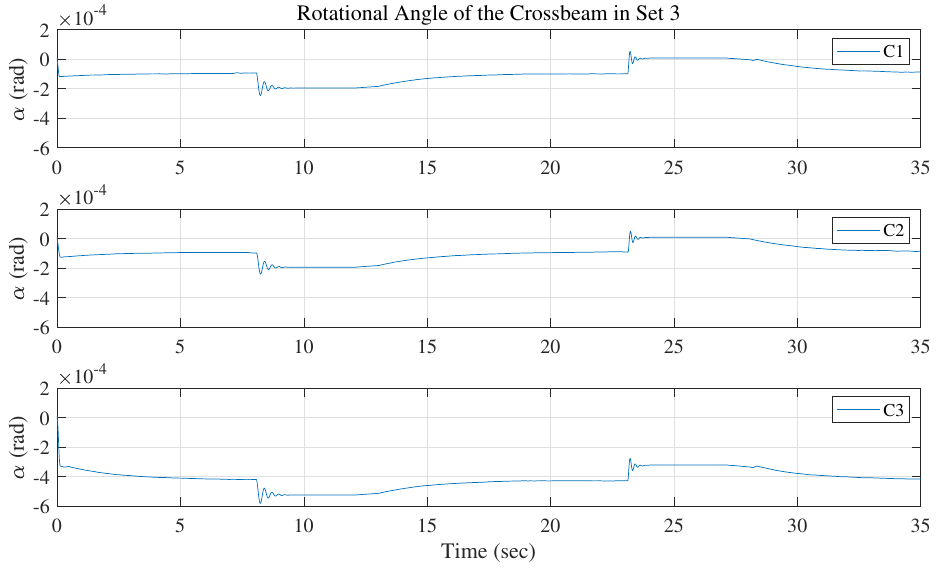
Figure 14. Rotational angles comparison in Set